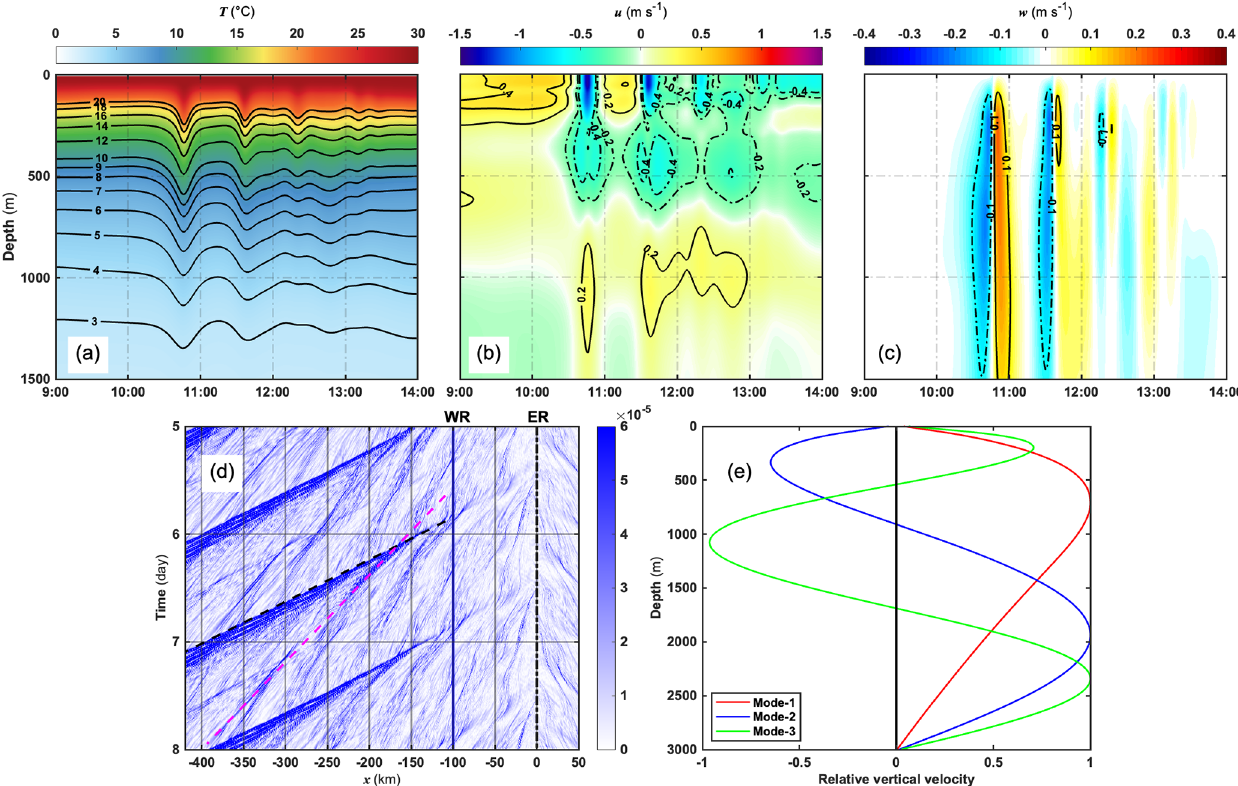
Figure 20. (a) The temperature ( ◦ C), (b) horizontal baroclinic velocity (ms − 1 ) , and (c) vertical velocity (ms − 1 ) structures of the first-mode ISW packet at x = − 250km on the sixth day. (d) The SSHG Hovmöller diagram during the associated period, with the black and magenta dashed lines indicating the first- and second-mode ISW packets. (e) The normal-mode profiles of vertical velocity for the first three modes using the Taylor–Goldstein